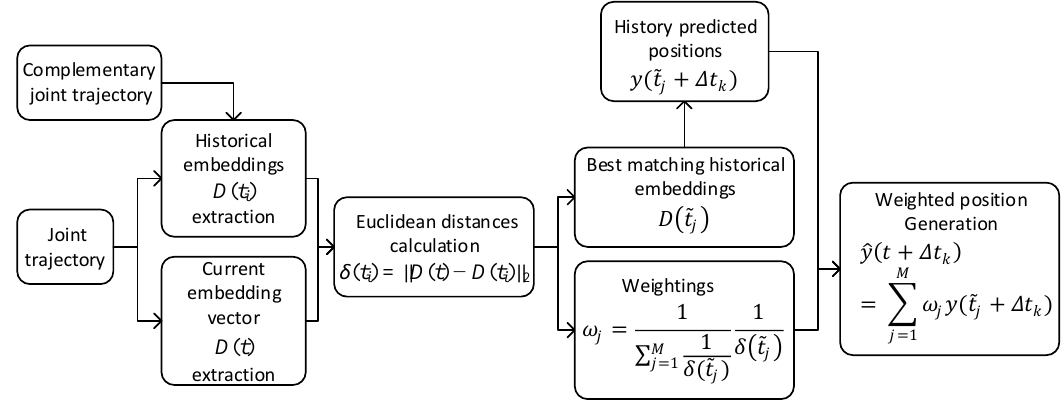
Figure 4. Synergy improvement method (1) of Takens’ reconstruction-based